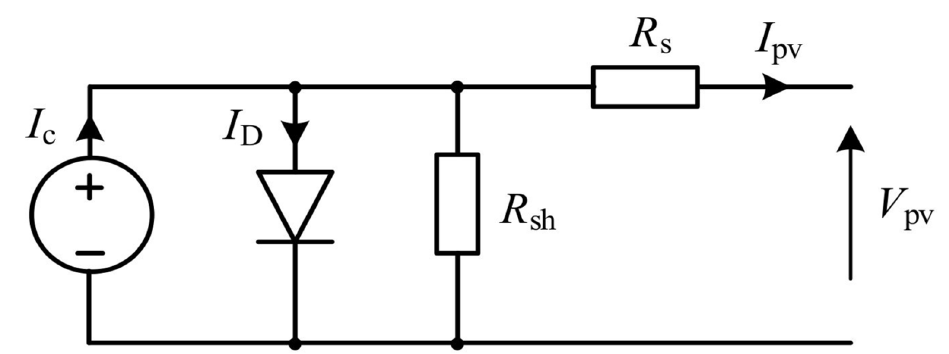
Figure 2. PV solar cell’s equivalent circuit.